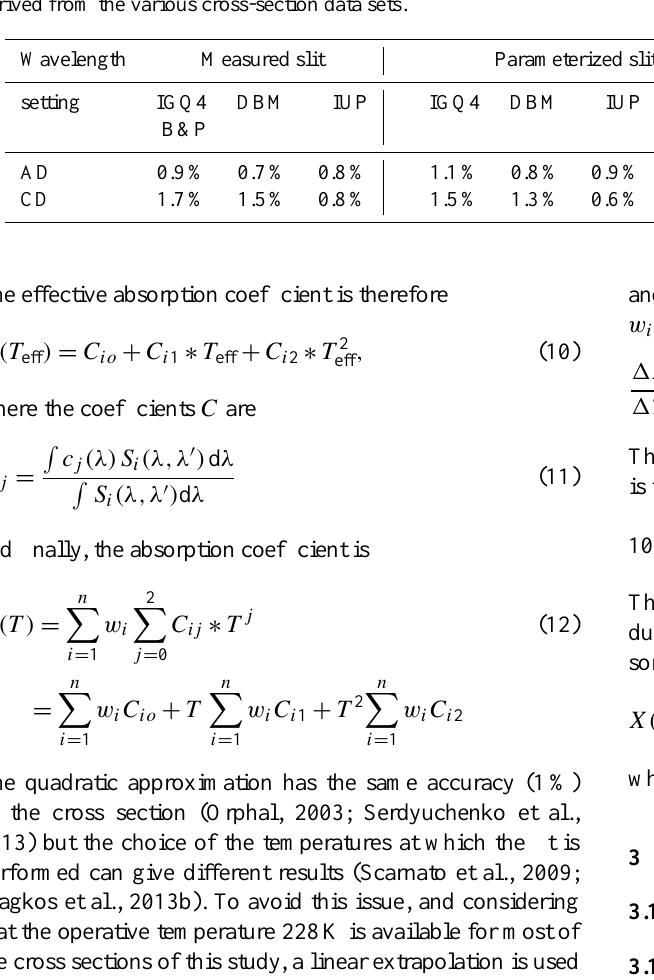
Table 3. Change in calculated ozone for the double wavelength pair combinations from the standard absorption coefficients to the ones derived from the various cross-section data